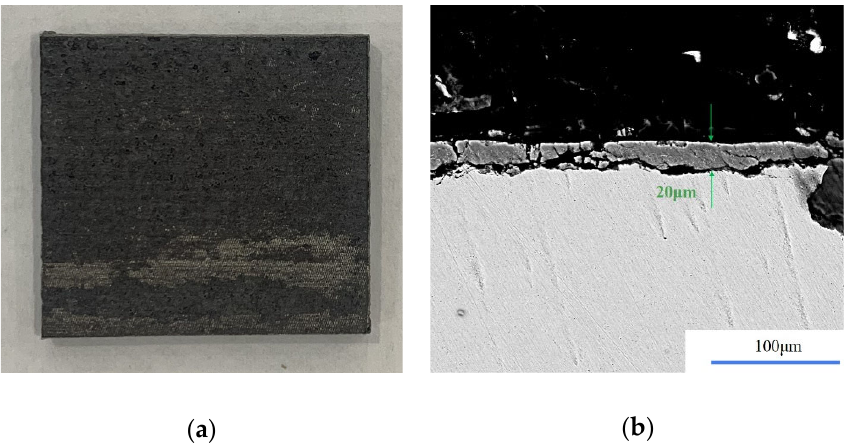
Figure 11. Morphology and thickness of residual dirt after cleaning twice. ( a ) Morphology of sample after cleaning; ( b ) thickness of residual oxide.